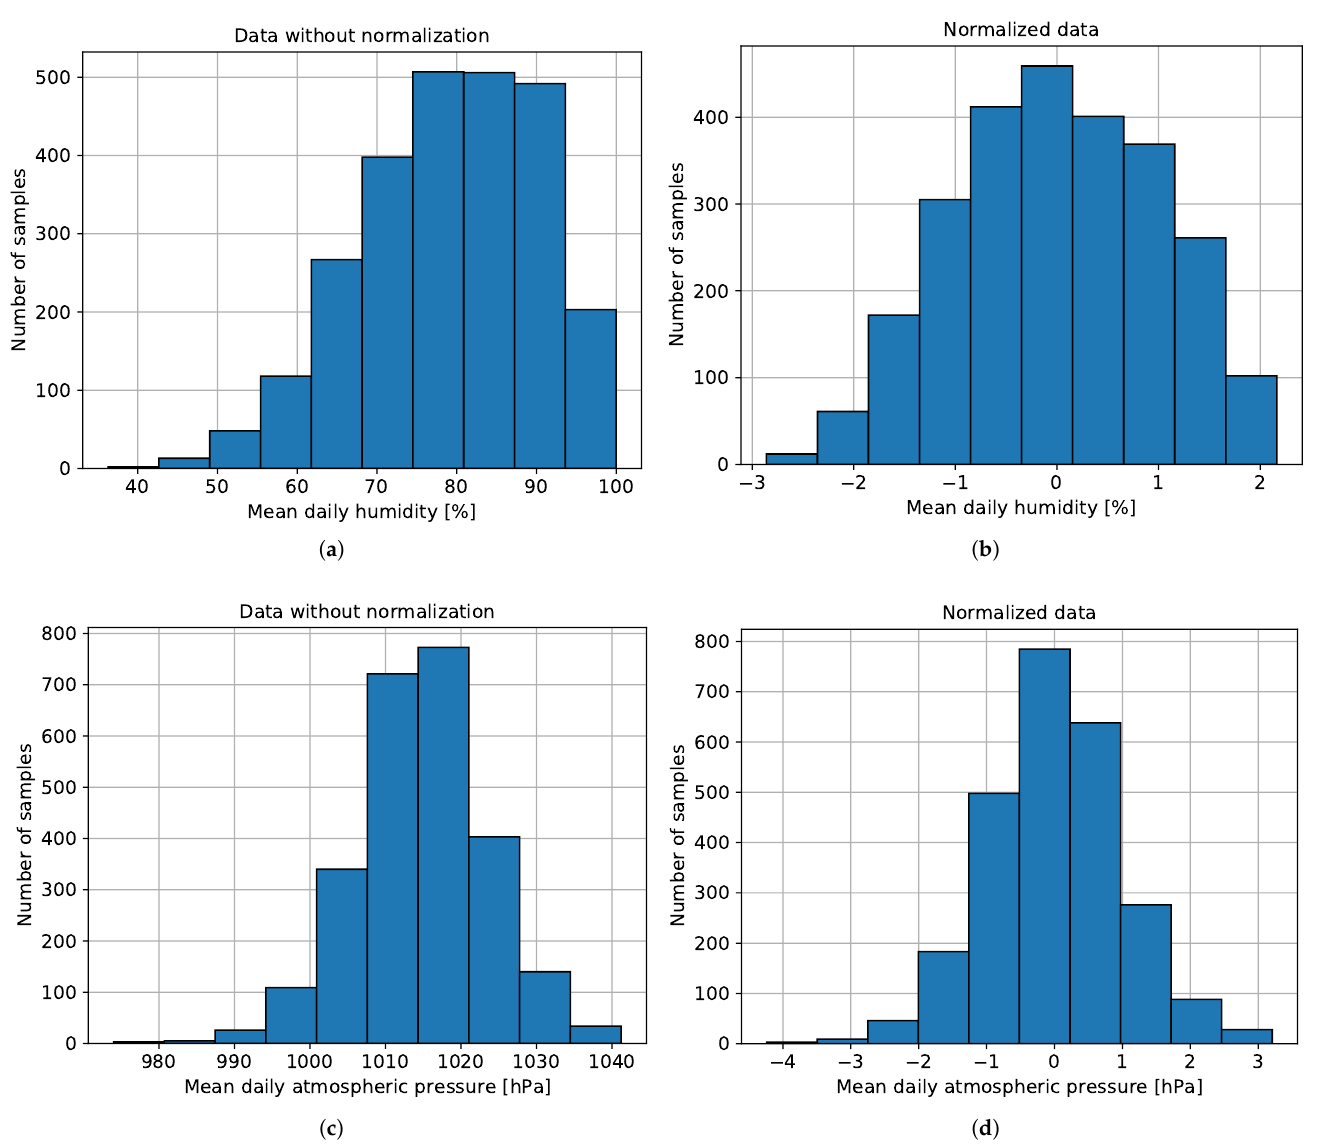
Figure A4. Input data histograms (the mean daily relative humidity before ( a ) and after normalization ( b ), and mean daily atmospheric pressure before ( c ) and after normalization ( d